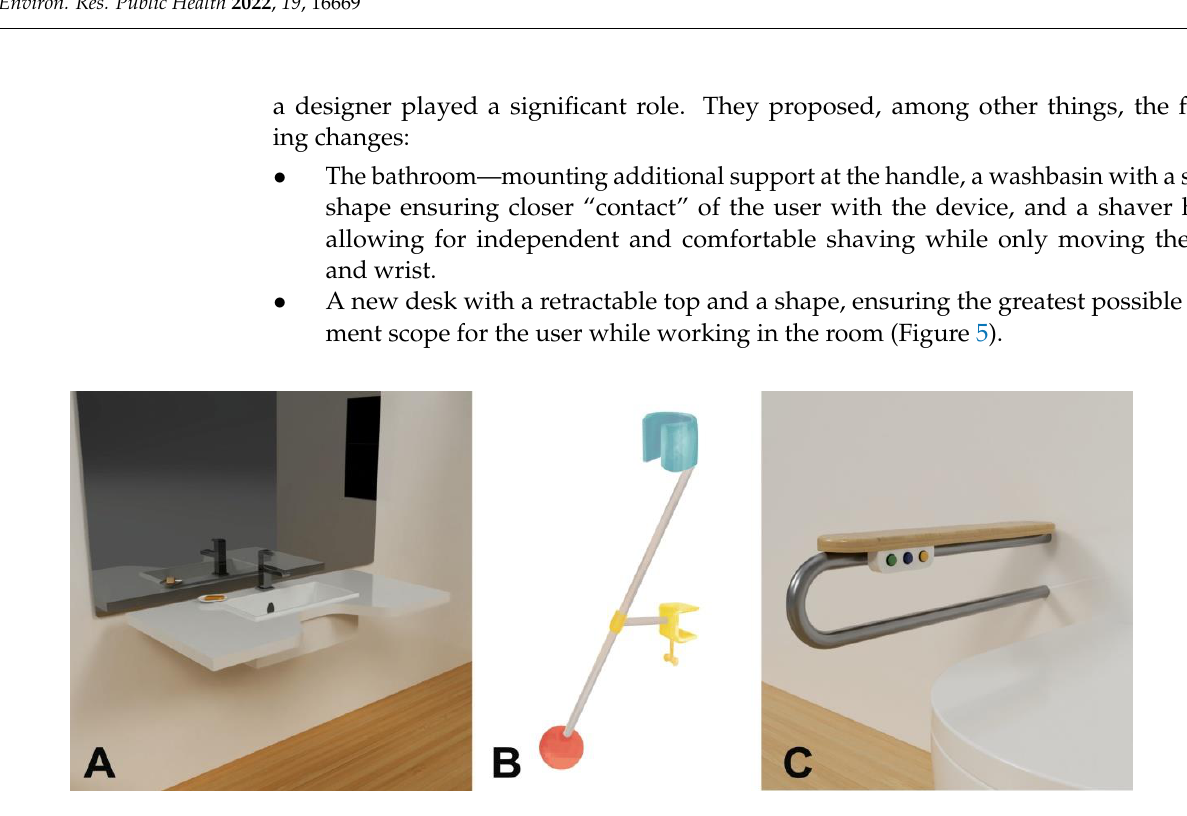
Figure 4. Design of individual devices for an investor with muscle atrophy: ( A )—washbasin, ( B )—shaver holder, ( C )—support for the handle (picture: Students participating in the 8th edition of JAI).